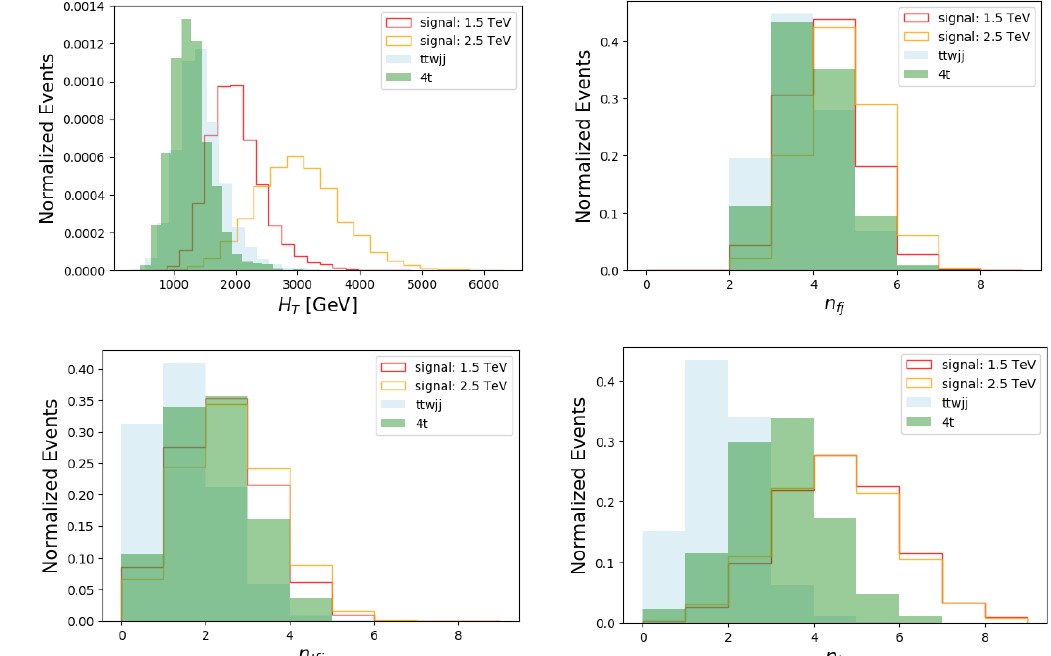
Figure 3 . The distribution of H T (top left), n fj (top right), n tfj (bottom left) and n b (bottom right) of the signal and backgrounds for the 3 mixed sign leptons case. Two choices of the top partner mass, m t 0 , are presented: 1.5 TeV (red line) and 2.5 TeV (orange